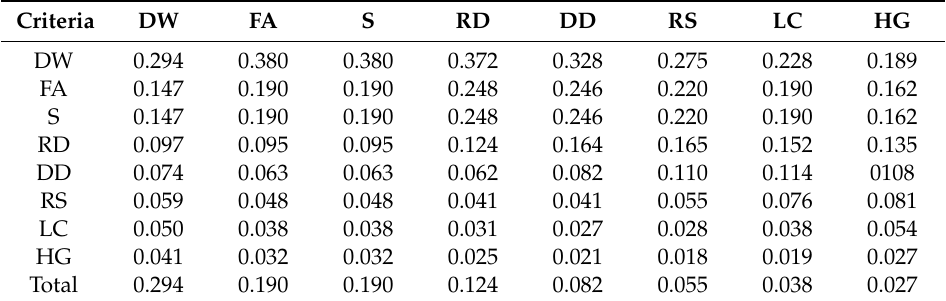
Table 7. Relative weight matrix, according to importance values between criteria.